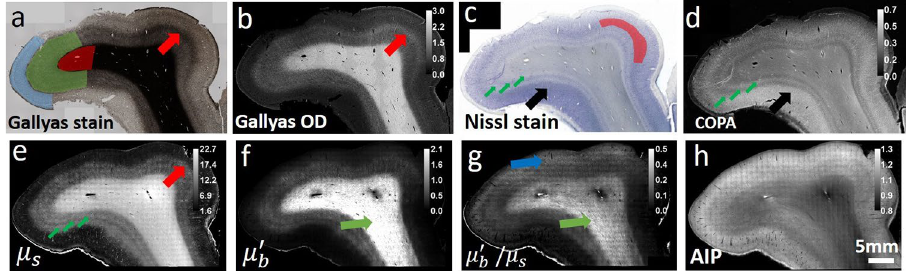
Figure 1. Histology and OCT optical property maps of the human somatosensory cortex. (a) Gallyas Silver stain shows contrast for myelin content. Red region: white matter. Green region: infragranular layers consist of layer IV, V and VI. Blue region: supragranular layers consist of layer I, II and III. Red arrow indicates a thin band of higher myelin content inside layer IV. (b) Optical density (OD) of Gallyas silver stain. The red arrow highlights the myelinated band inside the layer IV. (c,d) Nissl statin and COPA show contrast for cell bodies. The red region indicates the layer II and III with highest COPA value. The big black arrow highlights the high neuron density region. The small green arrows highlight the IV, V, VI layers within the infragranular layer with alternating contrasts. (e–g) Optical properties derived from the OCT images. (e) µ s map. Small green arrows highlight the alternating contrasts in the infragranular layers similar to that in the COPA map, and the ′ big red arrow indicates the myelinated band seen in Gallyas OD map. (f) µ b map. Green arrow highlights the ′ fibers with high intensity, possibly oriented within the imaging plane. (g) Ratio map of µ b /µ s . Green arrow ′ highlights the fibers with high intensity, similar to that in the µ b map. The Blue arrow highlights the region with high signals in the supragranular layers. (h) OCT average intensity projection (AIP)